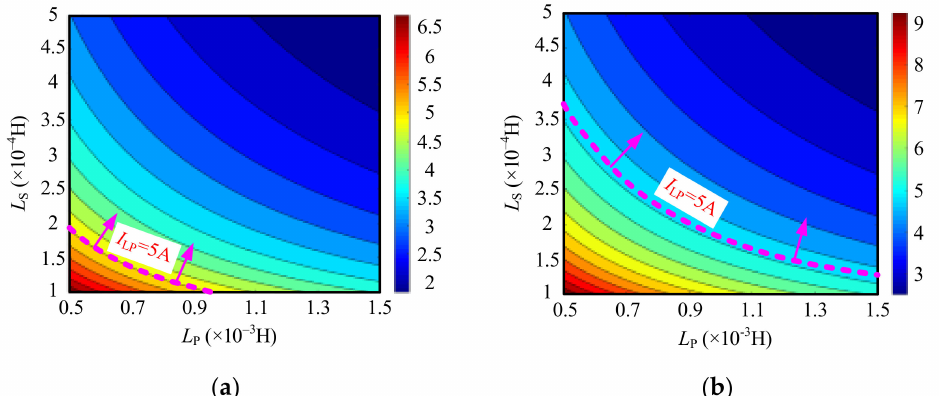
Figure 6. Changes of primary side current with primary and secondary side self-inductance before and after misalignment. ( a ) Alignment; ( b ) Offset to farthest